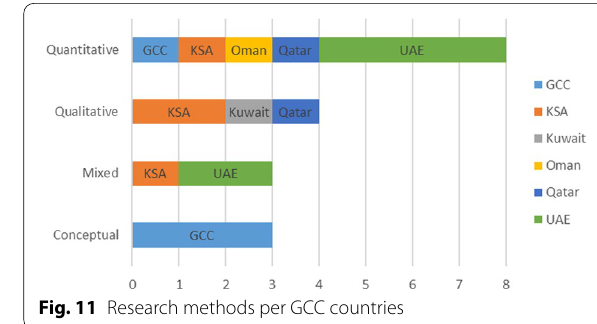
Fig. 11 Research methods per GCC countries